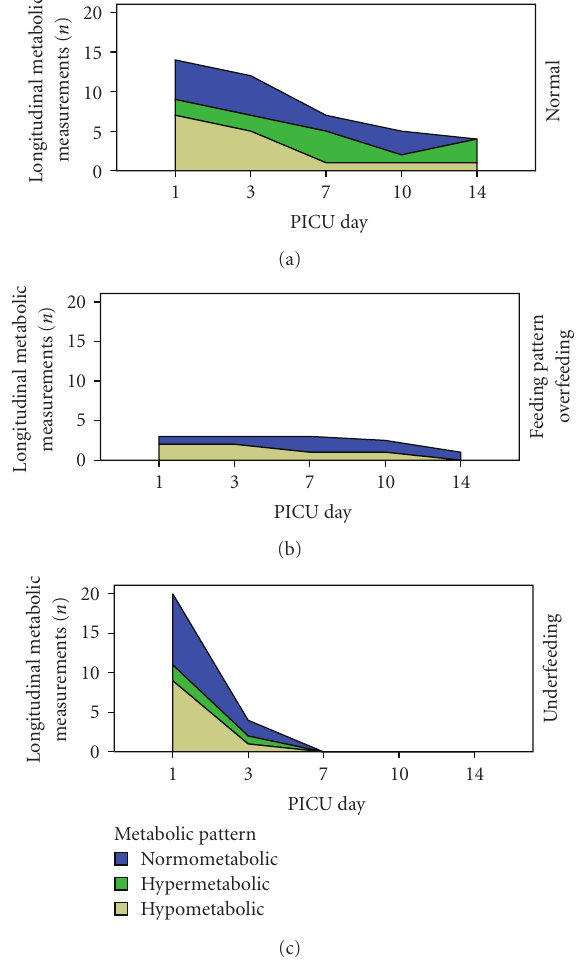
Figure 4: Longitudinal distribution of metabolic patterns in children during the acute phase of stress. The predominance of the hypometabolic pattern (50%) declined within 1 week of acute stress (20%) and the hypermetabolic patterns dominated only after 2 weeks (60%). Paired Resting Energy Expenditure (REE) and Predicted Basal Metabolic Rate (PBMR) measurements ( n =